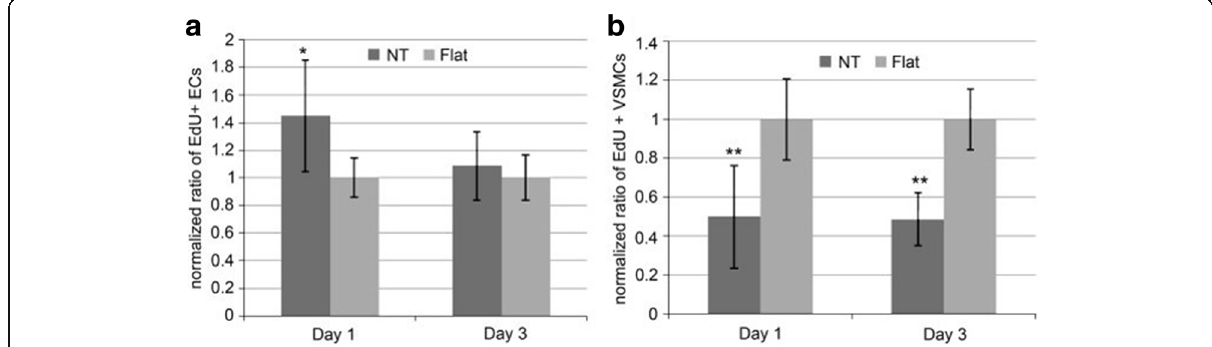
Fig. 10 Ratio of EdU positive a ECs and b VSMCs on flat or nanotube substrate. It is normalized by the average proportion of positive cells on flat surfaces on day 1 and 3. Data is presented as average ± standard deviation. * p < 0.05, ** p < 0.01 versus same day flat control, n = 6 reproduced from ref.